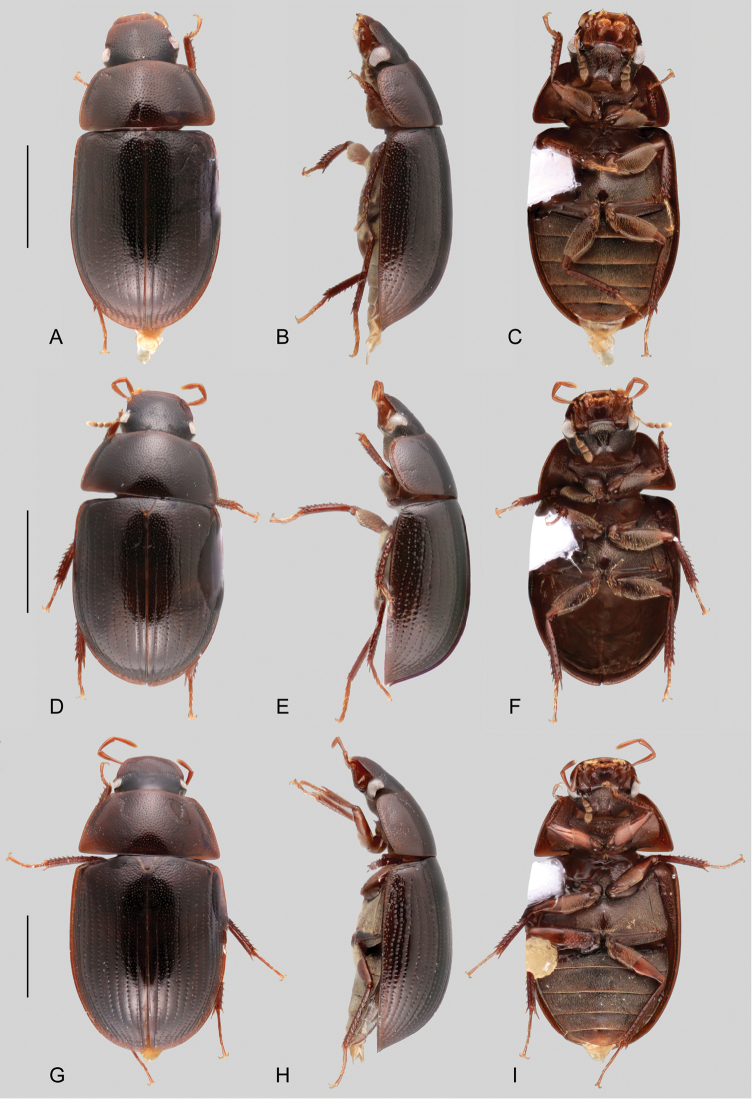
Habitus of Primocerus spp.: A–CPrimoceruspetilus: A dorsal view B lateral view C ventral view. D–FPrimocerusstriatolatus: D dorsal view E lateral view F ventral view. G–IPrimocerussemipubescens: G dorsal view H lateral view I ventral view. Scale bars: 1 mm.